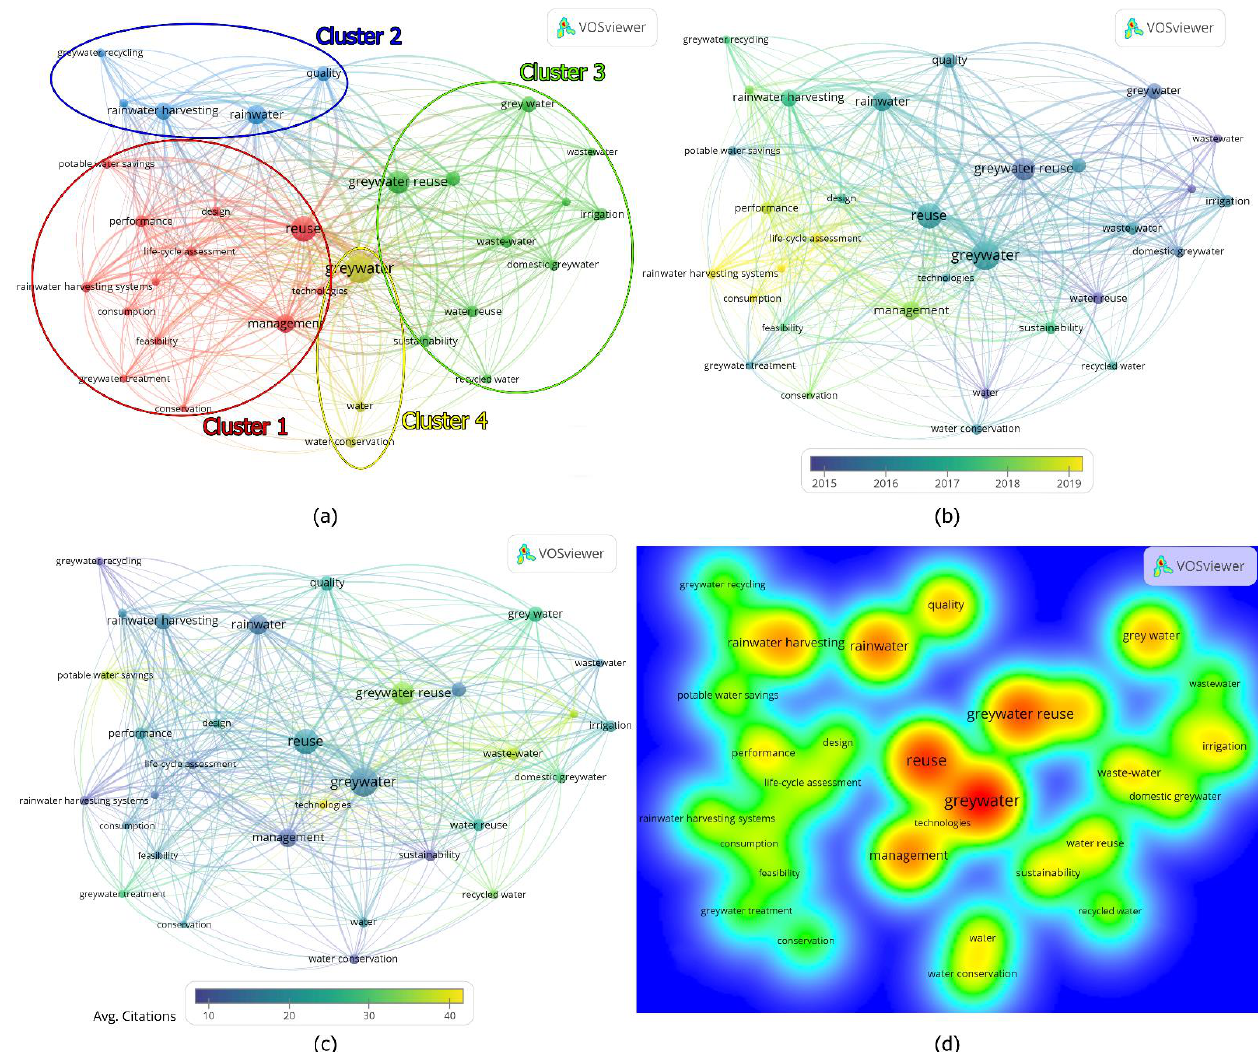
Figure 9. The keywords co-occurrence network of greywater recycling papers: ( a ) Clusters distribu- tions; ( b ) Timeline of occurrences ( c ) Average number of citations; ( d ) Density view. Table 10. The most popular keywords in greywater recycling domain.